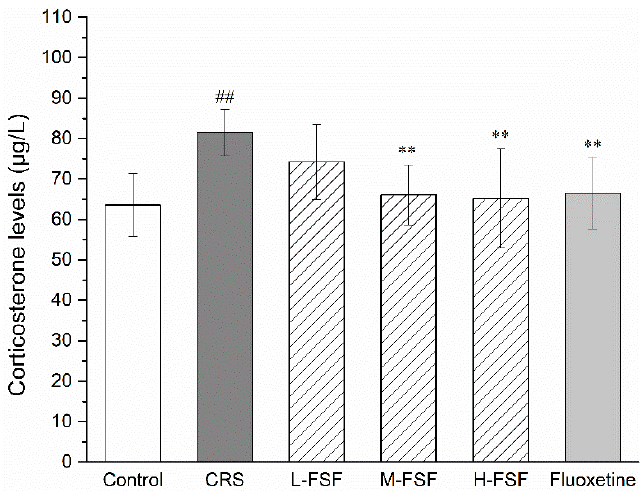
Figure 5. Effects of FSF on serum corticosterone level in mice. n = 10, ## p < 0.01, vs. Control group; ** p < 0.01, vs. CRS group.